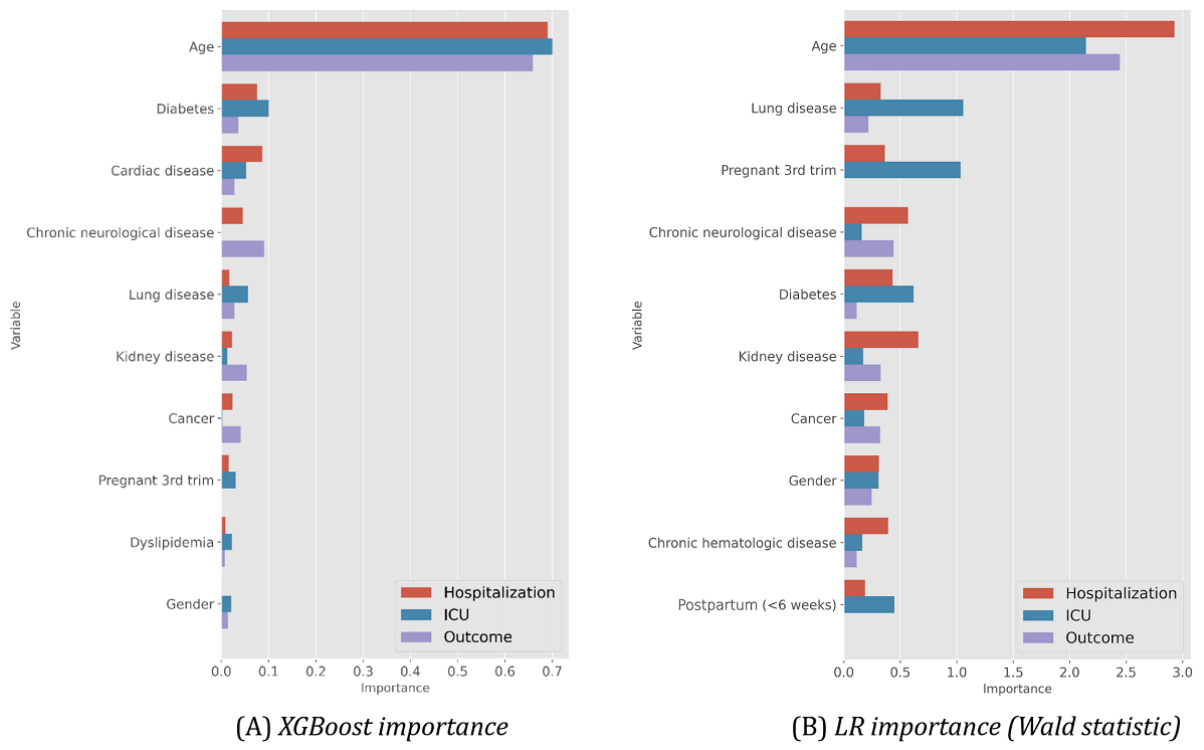
Figure 11. Top features and their importance for each target variable at the time of SARS-CoV-2 testing (prehospitalization). ICU: intensive care unit, LR: logistic regression.